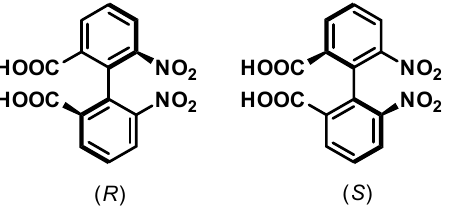
Figure 1. Enantiomers of the biaryl 6,6’-dinitro-2,2’-diphenic acid.